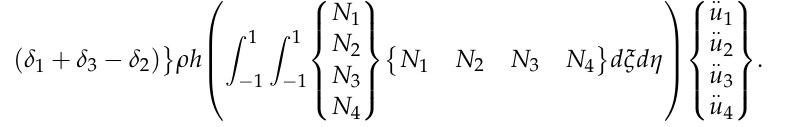
Table 2. Integral form of shape functions products.